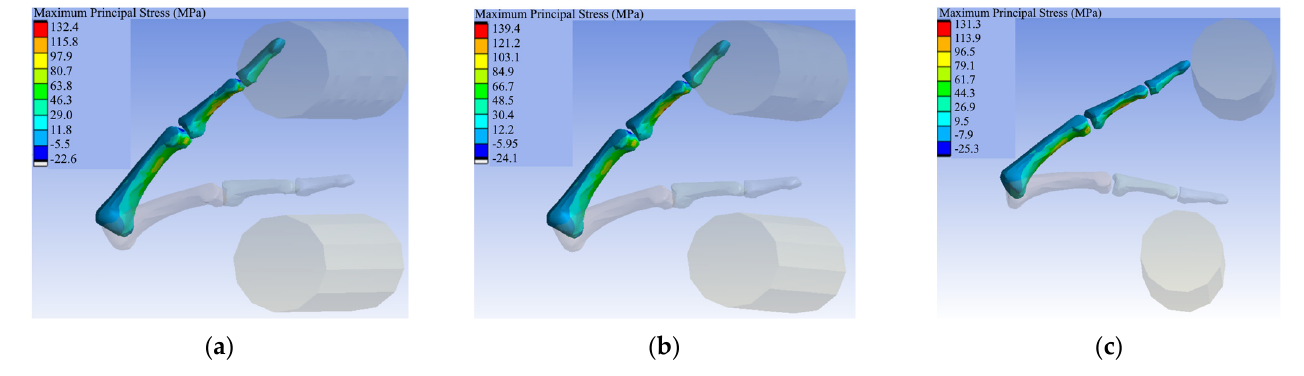
Figure 9. Principal stress under hyperextension for effective masses ( a ) 3.6, ( b ) 7.2, and ( c ) 14.4 kg.